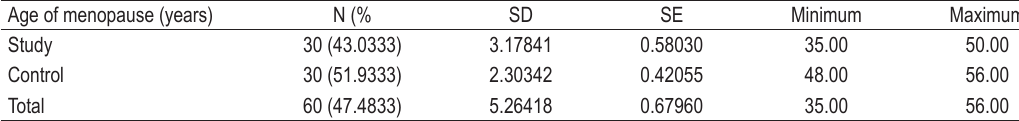
TABLE 2. Comparison of average age of menopause by